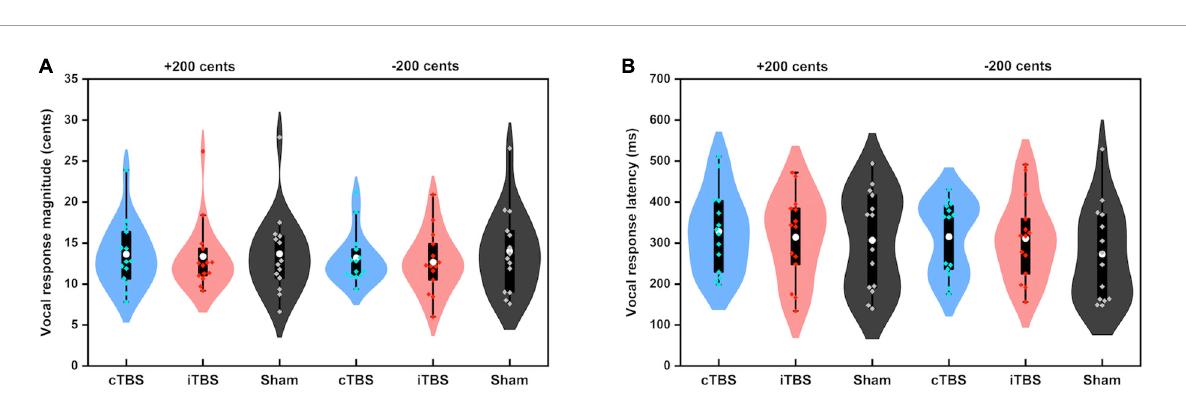
FIGURE4 Violin plots of the peak magnitudes (A) and times (B) of vocal responses to ± 200 cents produced by all participants across the conditions. The shape of the violin shows the kernel density estimate of the data. The white dots and box plots represent the medians and ranges from first to third quartiles of the data sets. The blue, red, and black dots represent the individual vocal responses to pitch perturbations following cTBS, iTBS, and sham stimulation over the left cerebellar lobule VII (Crus I). CB,